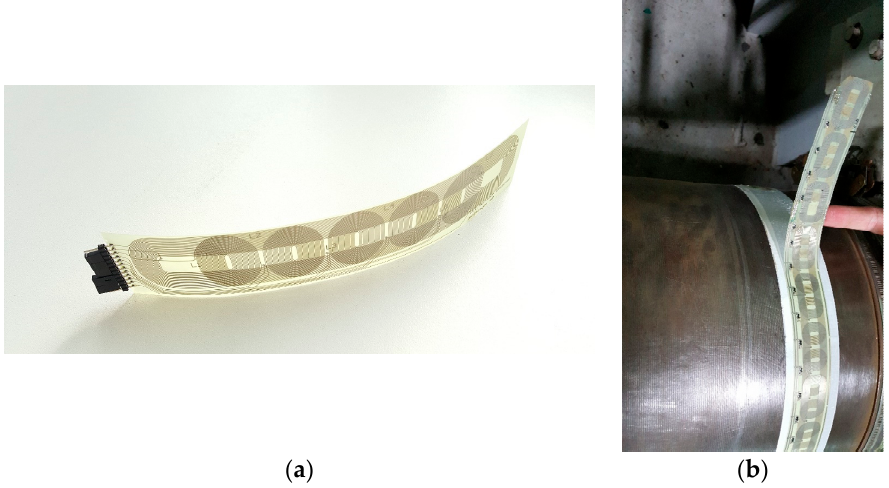
Figure 4. ( a ) Wireless power transfer secondary side (receiver Rx ) coils and ( b ) their exemplary arrangement on a main, marine shaft.